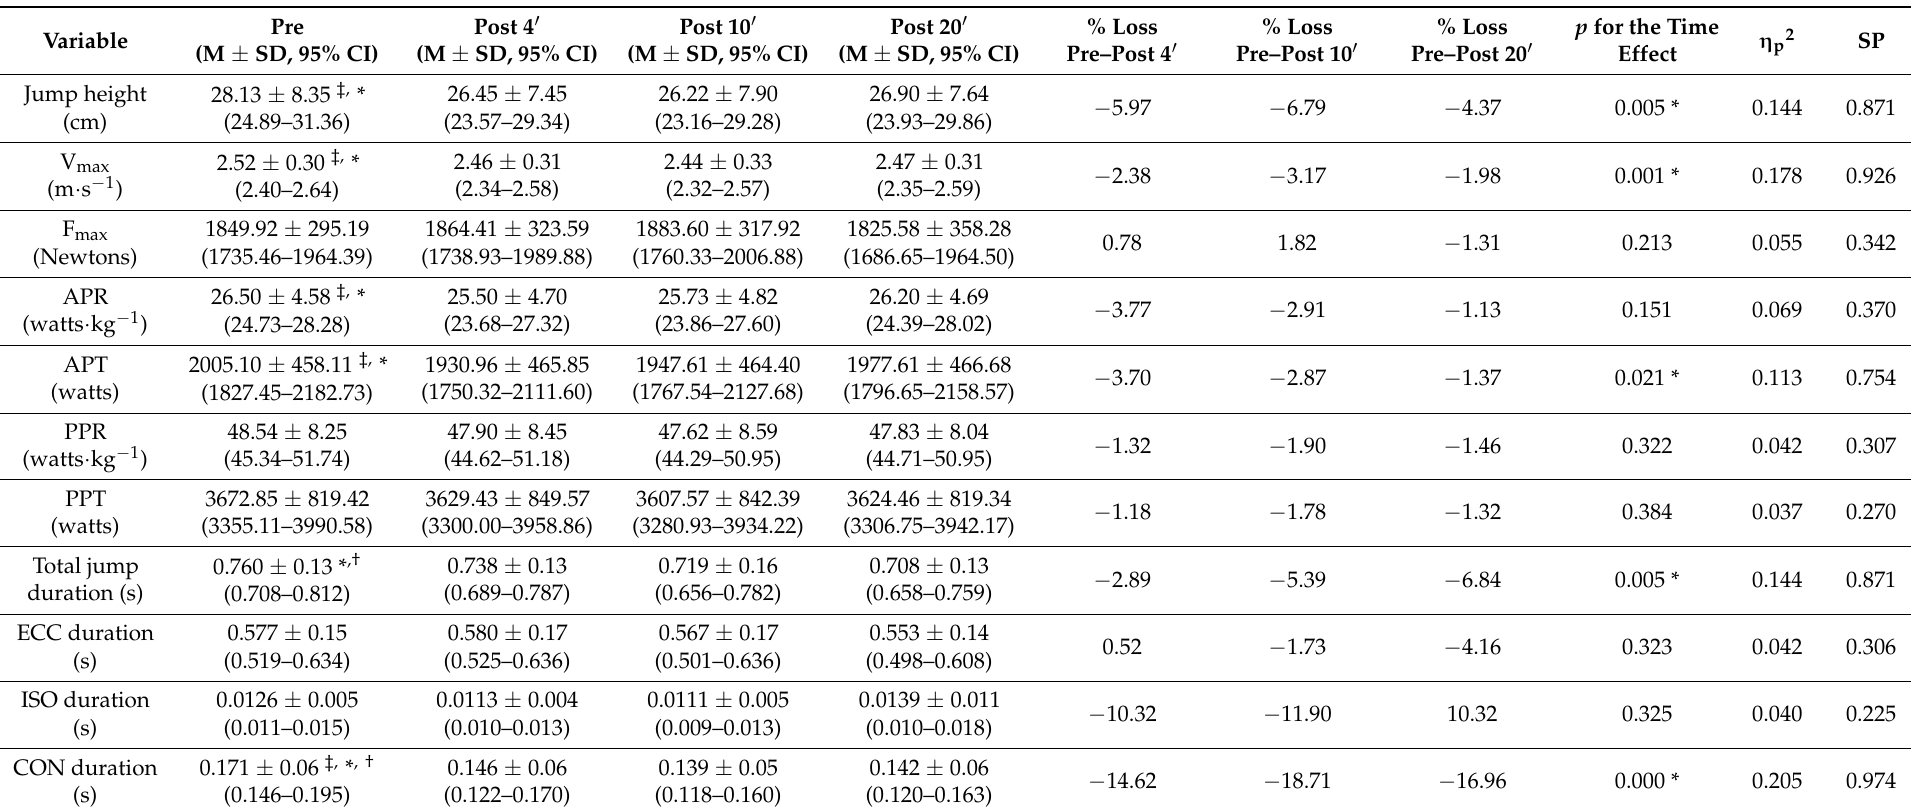
Table 3. Jump ability variables recorded preFFT and at postFFT minutes 4, 10, and